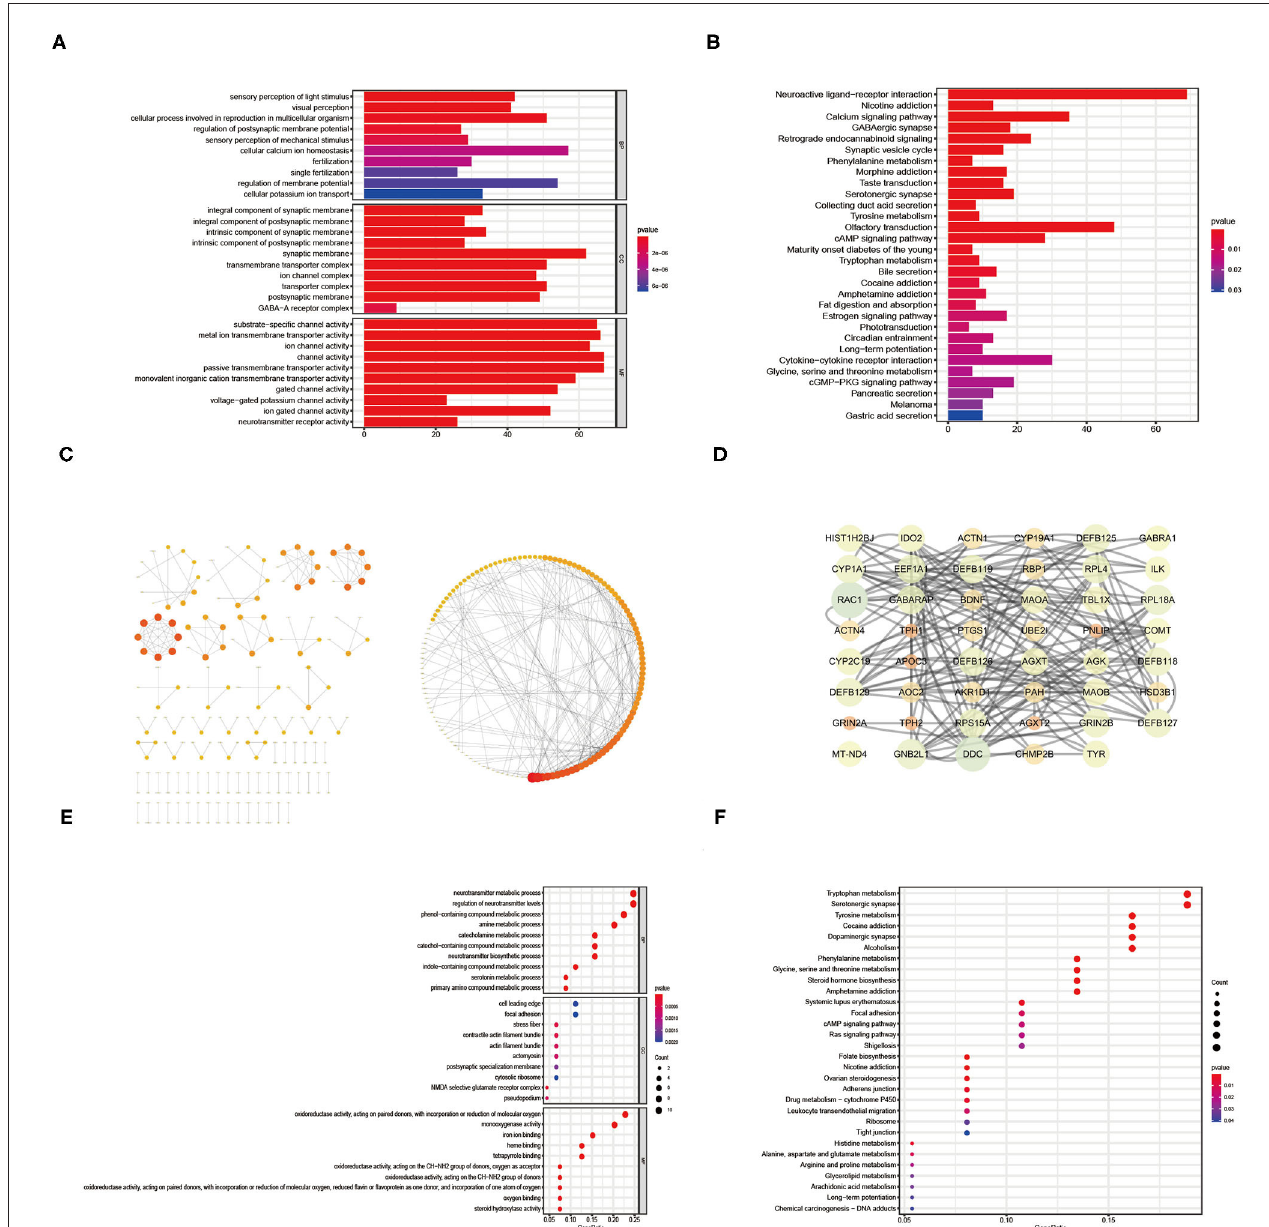
FIGURE 3 | The GO enrichment analysis, KEGG enrichment analysis and PPI network results of intersection genes between DEG and the Meorangered1 modules (A–C) . The GO enrichment analysis, KEGG enrichment analysis and PPI network results of hub genes from intersection genes between DEG and the Meorangered1 modules (D–F)